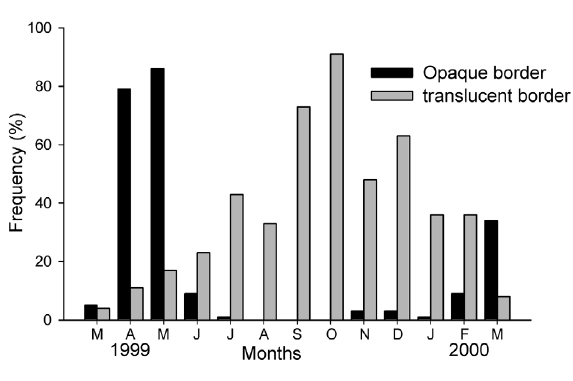
Fig . 3. – Monthly frequency of opaque and translucent margins of otoliths of H. didactylus sampled between March 1999 and March 2000 in the Bay of